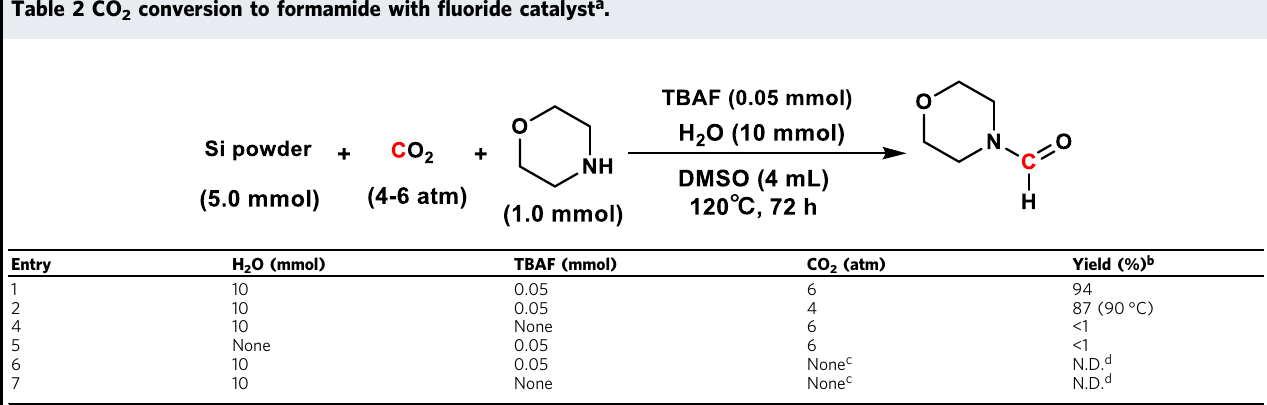
Table 2 CO 2 conversion to formamide with fl uoride catalyst a .